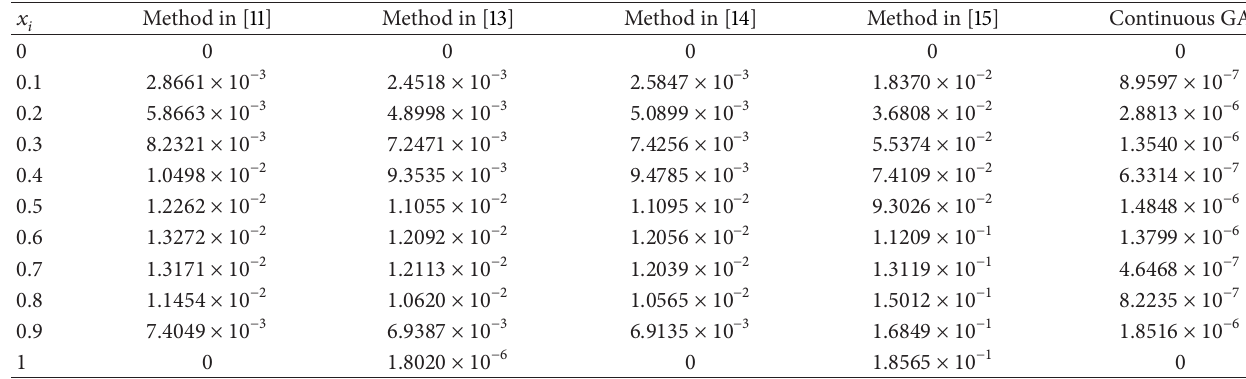
Table 6: Absolute error results for Troesch’s problem when 𝜆 = 1 .